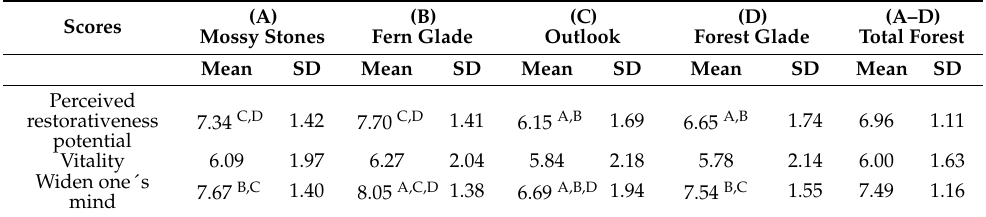
Table 1. Qualities of the places and the